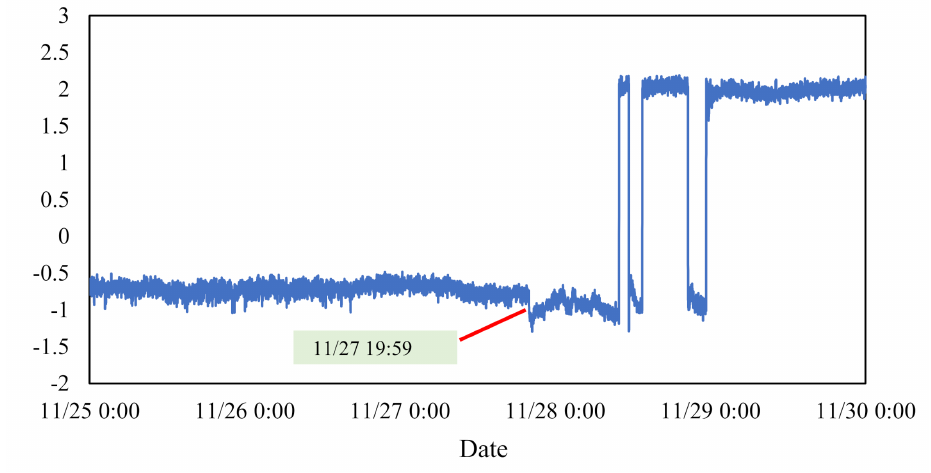
Figure 13. First principal component data after dimensionality reduction.